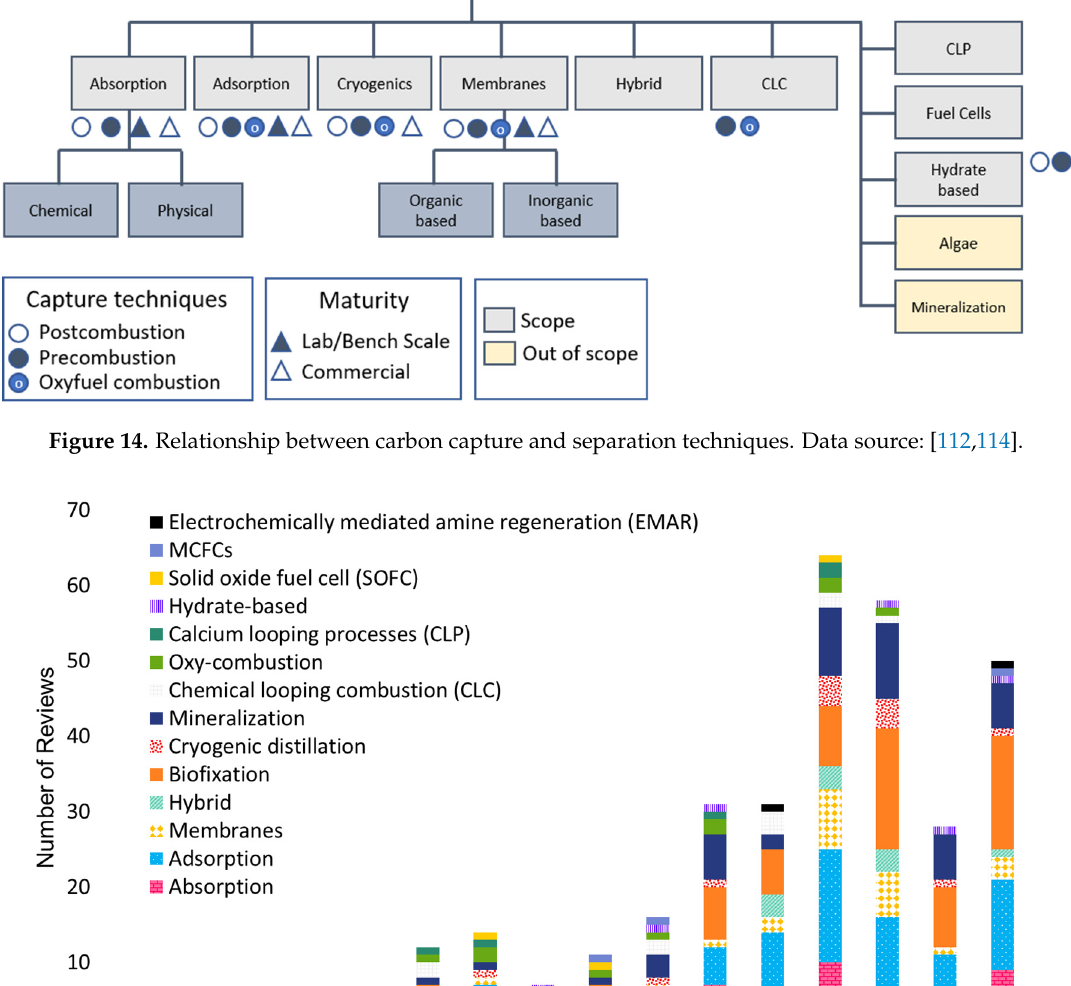
2 capture and separation techniques in review